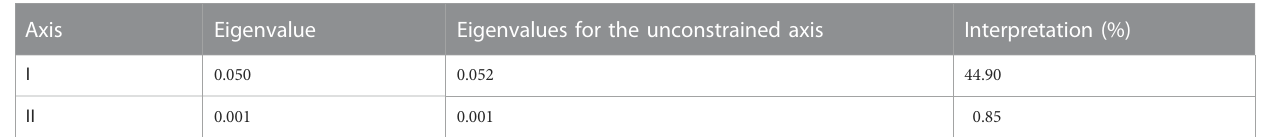
TABLE 3 Summary of RDA for trapped samples.